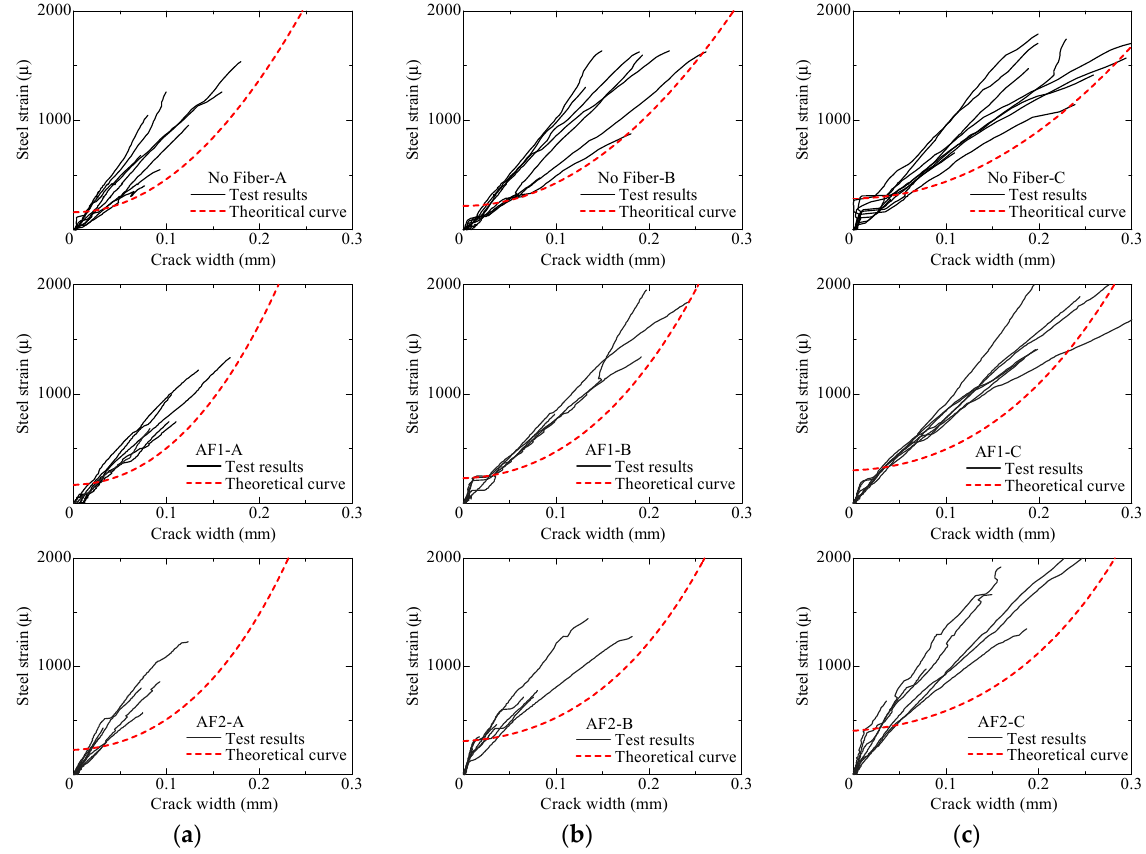
Figure 16. Comparison of theoretical curve and test result: ( a ) A series; ( b ) B series; ( c ) C series.